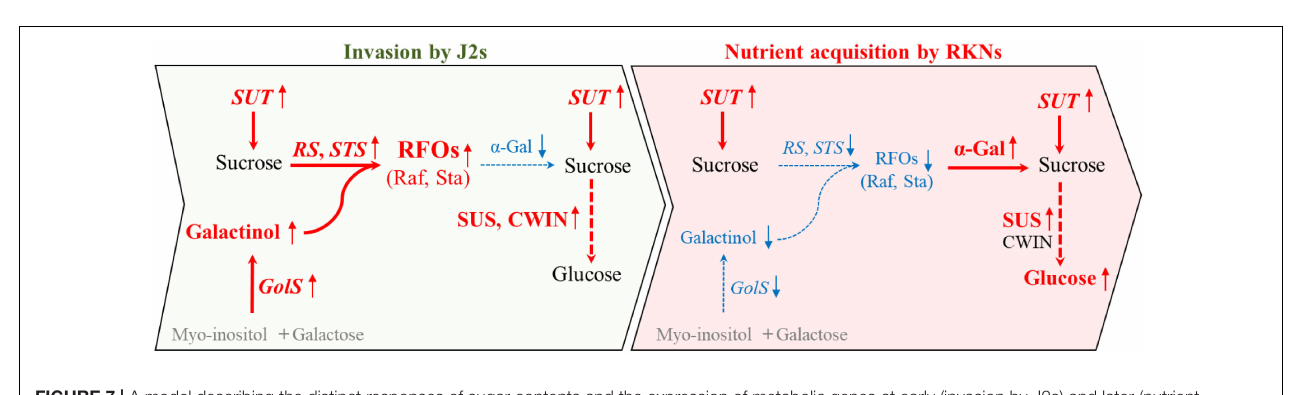
FIGURE 7 | A model describing the distinct responses of sugar contents and the expression of metabolic genes at early (invasion by J2s) and later (nutrient acquisition by RKNs) stages during infection. During the invasion of nematode in cucumber roots, CsGolS was induced and galactinol was synthesized with myo-inositol and galactose. Further, RFOs may be largely synthesized by CsRS and CsSTS from galactinol and sucrose which was transported by SUT at early stage, possibly for resisting the infection of nematode. Afterward, upon nematode development, RFOs may be cleaved to sucrose and galactose by α -gal. Furthermore, sucrose was degraded by SUS encoded into hexoses at early and late stage of nematode infection, providing energy and carbon to supply nematode development. Red font and blue font indicate increase and decrease after nematode infection compare with non-infection, respectively. Black font imply no differences between infected and non-infected by nematode. Gray parts have not been detected in this